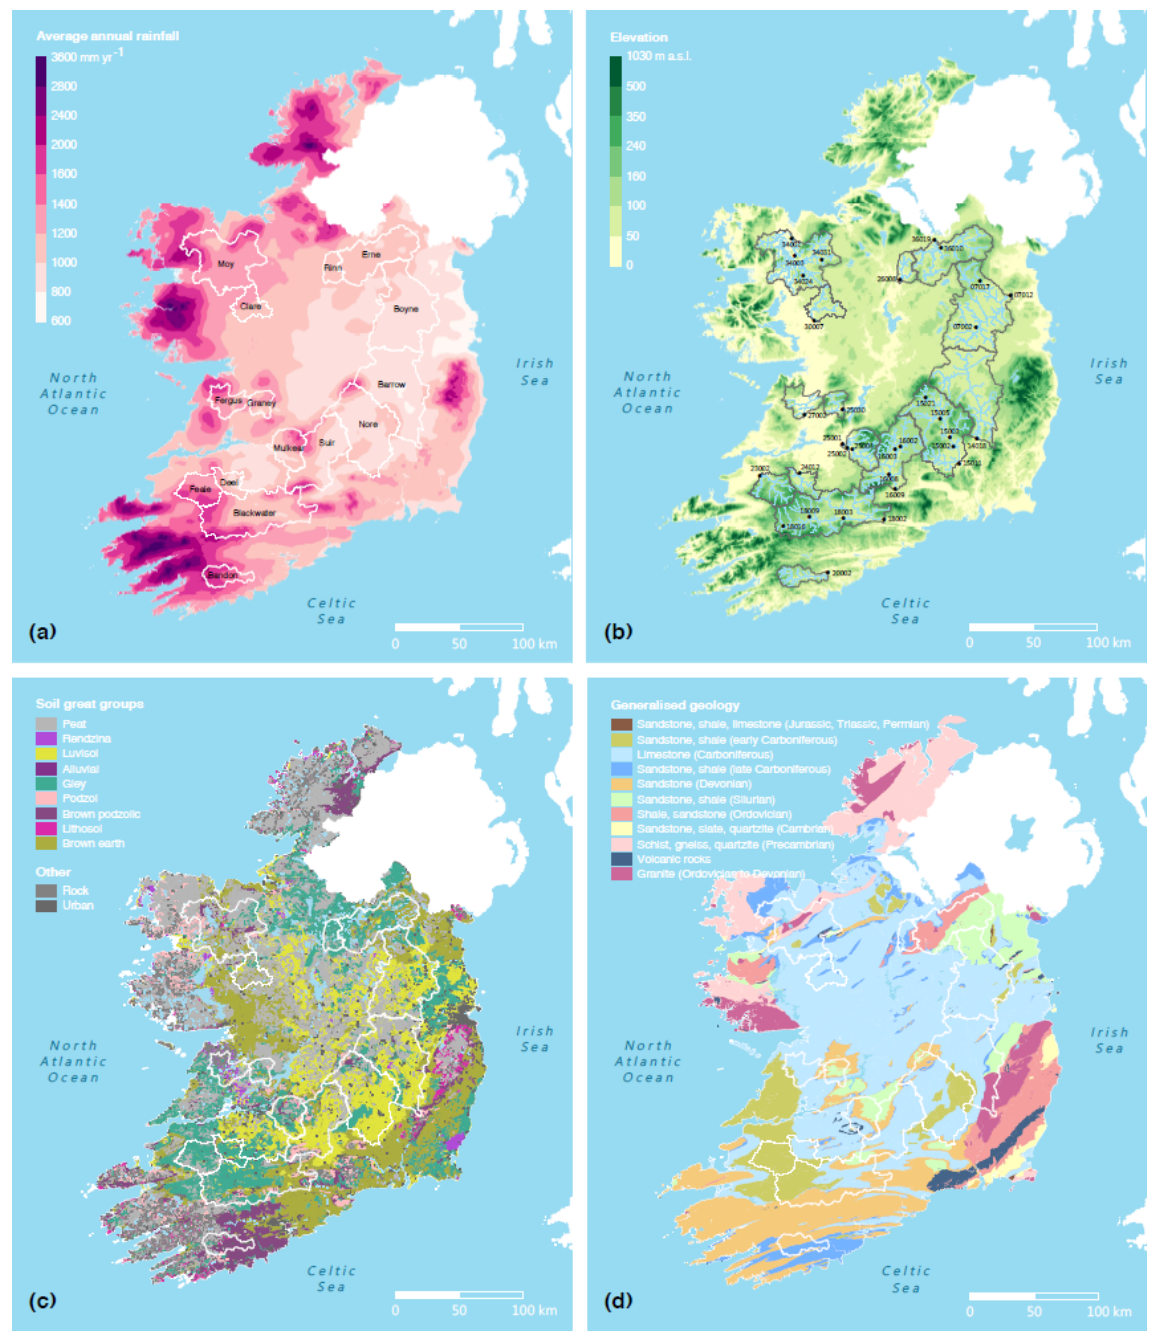
Figure 1. Spatial location and information on the study catchments: (a) map of the average annual rainfall for the Republic of Ireland for the period 1981–2010 (source: Met Éireann) overlaid with the 15 distinct river basins containing the 33 study catchments – each name corresponds to a river basin; (b) map of the topography for the Republic of Ireland (source: Ireland’s EPA) overlaid with the location of the 33 hydrometric gauges forming the 33 study catchments – each number corresponds to the code of a hydrometric gauge; (c) map of the pedology for the Republic of Ireland (source: Teagasc) overlaid with the outlines of the 15 river basins; (d) map of the geology for the Republic of Ireland (source: © Geological Survey Ireland) overlaid with the outlines of the 15 river